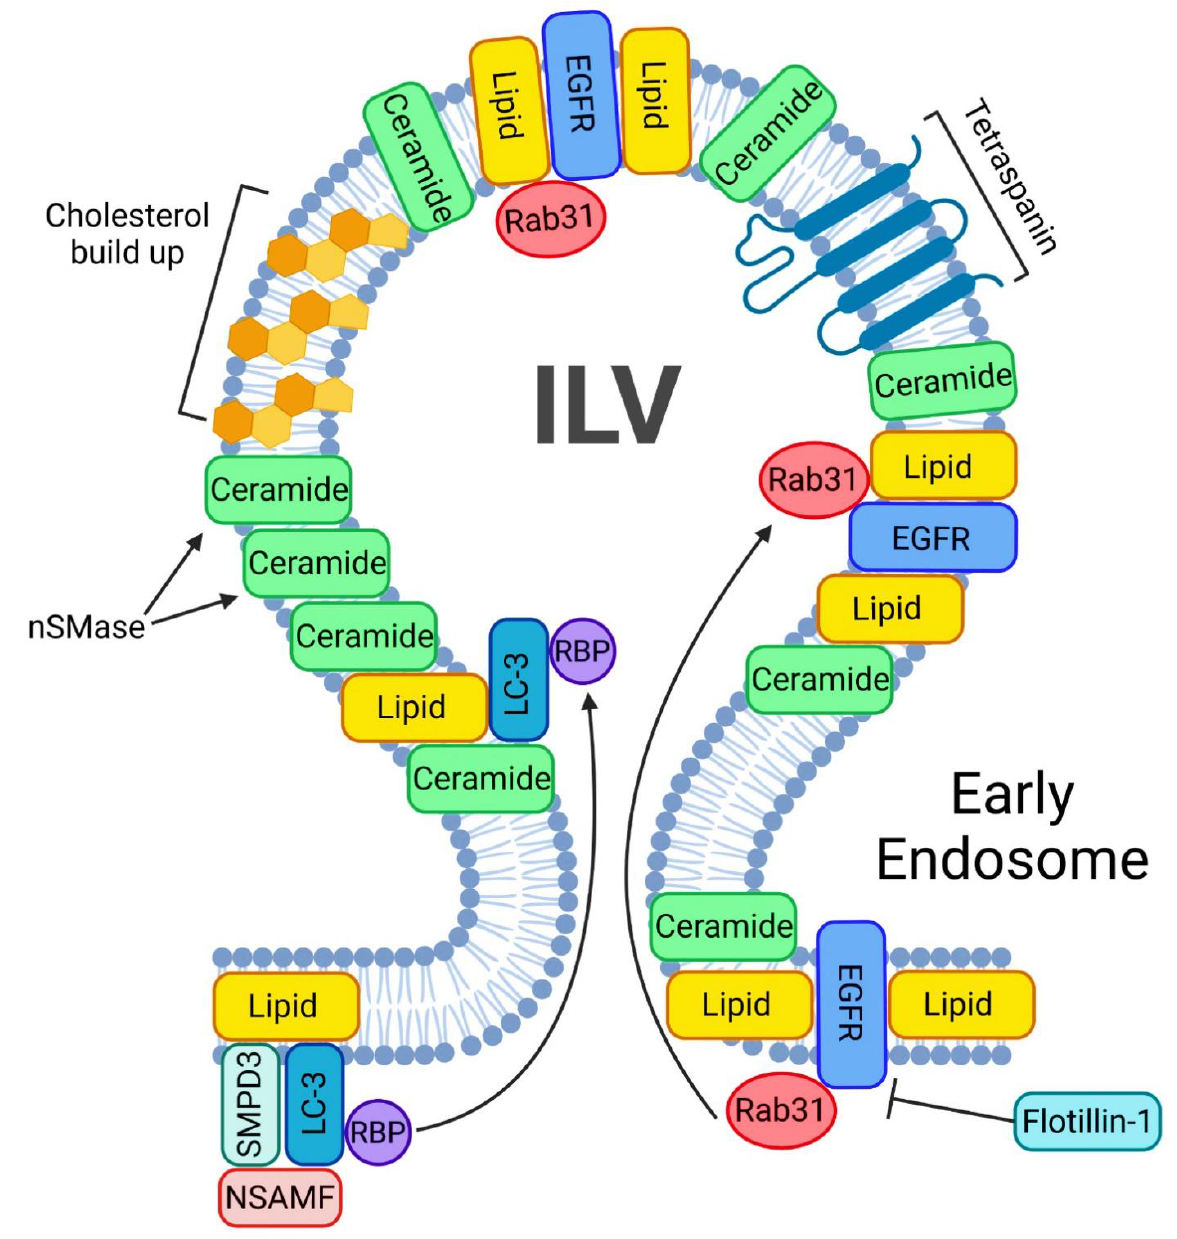
Figure 3. ESCRT-independent pathway of exosome biogenesis and release. A crucial step in starting the ESCRT-independent exosome biogenesis is the phosphorylation of Rab31. A phosphorylated Rab31 will allow flotillins to deliver the EGFRs into the ILV. nSMases will help accumulate ceramides inside the ILVs. In addition, such ILVs will be enriched in ceramides and cholesterol.